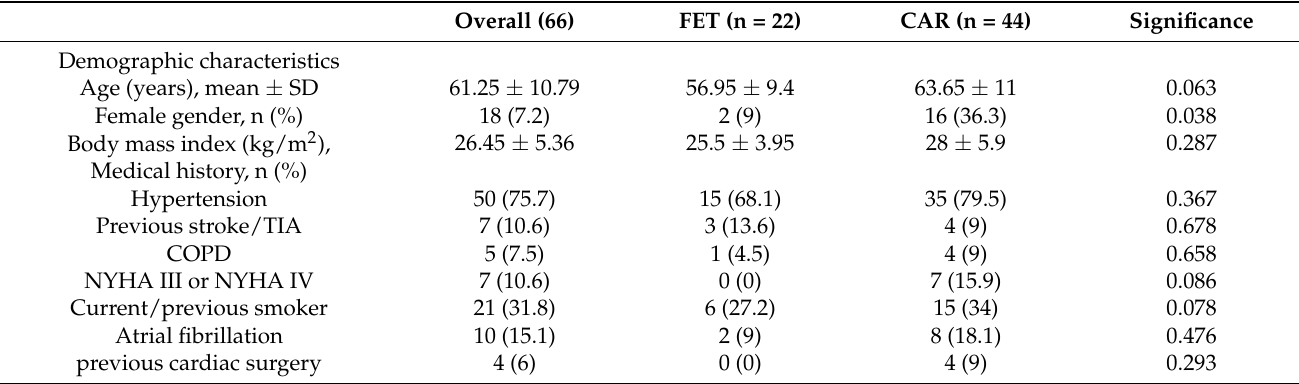
Table 1. Baseline characteristics of the study population. Overall (66) FET (n = 22) CAR (n = 44)